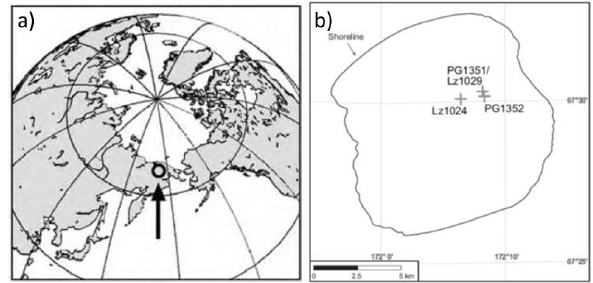
Fig. 1. (a) Location of Lake El’gygytgyn in Far East Russian Arc- tic, 67 ◦ 30 0 N, 172 ◦ 5 0 E (Nowaczyk et al., 2002). (b) Location of collected cores in Lake El’gygytgyn. Cores PG1351 and PG1352 were drilled in 1998, cores LZ1024 and LZ1029 were collected in 2003, and long cores were drilled in 2009 (not